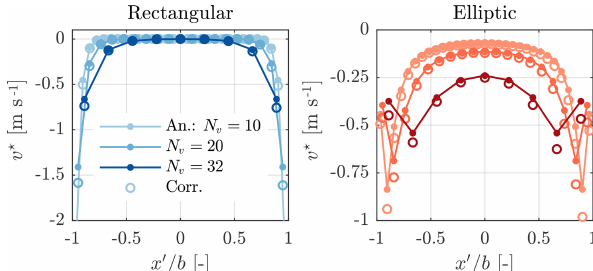
Figure 7. Analytical (An.) and corresponding model prediction of the velocity correction for varying force smearing ( (cid:15) = 2 b/ ( N v − 1)) along a rectangular and elliptic wing, where x (cid:48) = x − ( b + r v = 1 ).